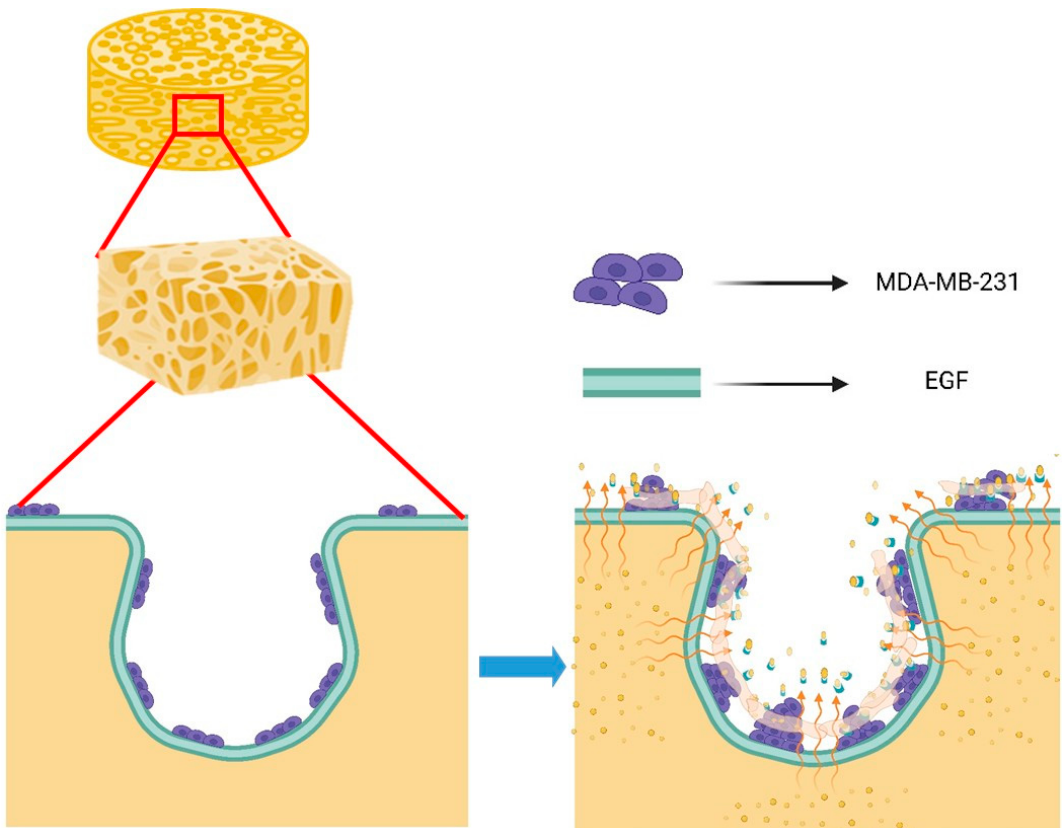
Figure 8. Schematic diagram of dynamic scaffolding three-dimensional hypothesis: While MDA-MB-231 adhered to the scaffold, its proliferation was flattened; the EGF was immobilized, and thus, the scaffold degraded into small fragments that were distributed around the pores inside the scaffold, and the MDA-MB-231-MDA-MB-231 interaction between the scaffold and the fragments was directed towards spheroids. (This Figure was created with BioRender.com (accessed on 12 August 2022)).